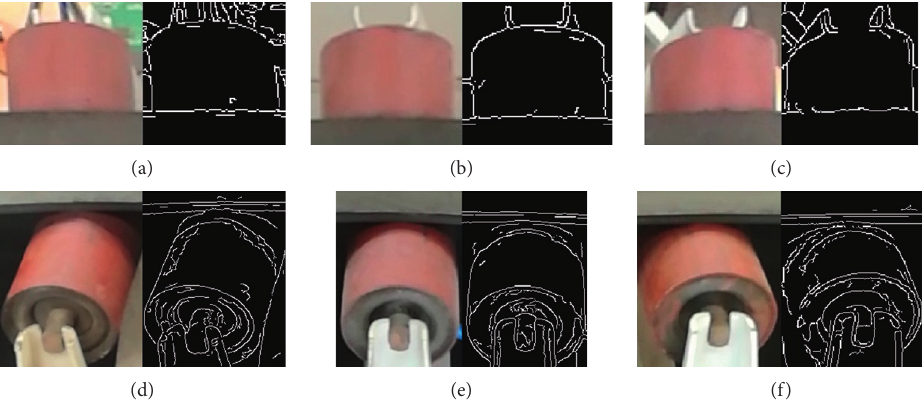
Figure 2: Typical images of the ROI and their edge maps. With the movement of the inspection robot, the position of the ROI in the image changes from left to right, the idler outer edge presents an elliptical arc, and the edge map of the ROI_I is disturbed by similar elliptical arcs. (a) ROI_O on the left, (b) ROI_O in the middle, (c) ROI_O on the right, (d) ROI_I on the left, (e) ROI_I in the middle, and (f) ROI_I on the right.